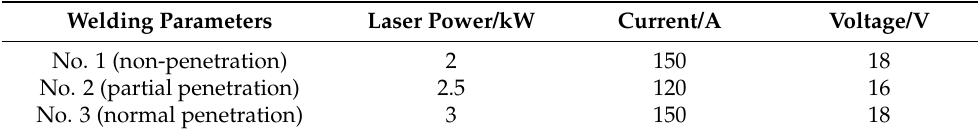
Table 1. Experimental conditions of laser-MIG hybrid welding. Welding